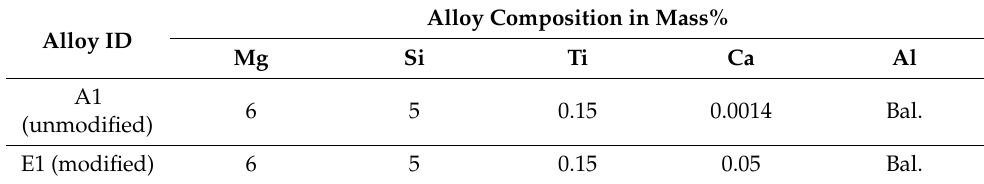
Table 1. Chemical composition of examined alloys.